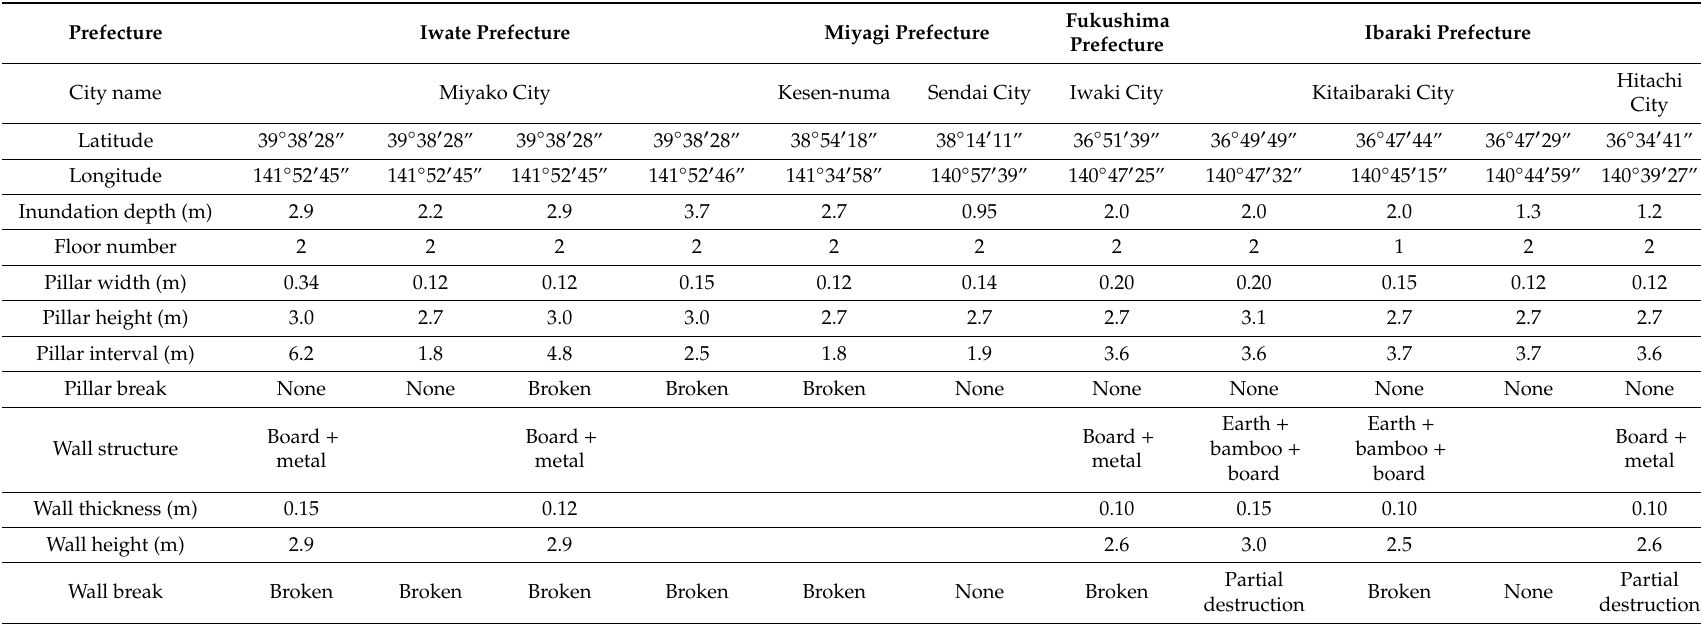
Table 3. Wooden house damage survey results for the 2011 Great East Japan Earthquake tsunami.